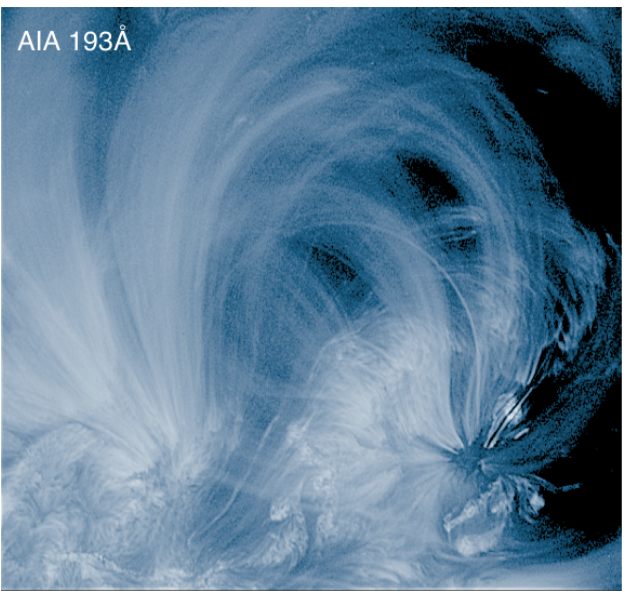
Figure 5: SDO/AIA (193 ˚A channel) image of finely-structured coronal loops (14 October 2011, 22:56 UT). The image was treated with a Gaussian sharpening filter with a radius of 3 pixels. Image reproduced with permission from Brooks et al. (2012), copyright by